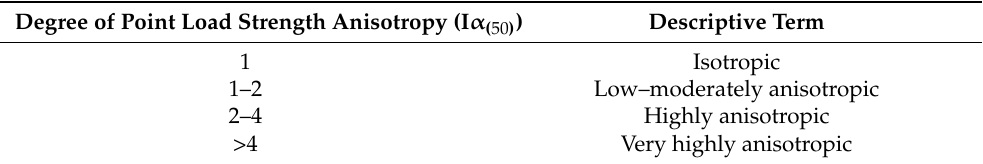
Table 7. Anisotropy classification based on point load index